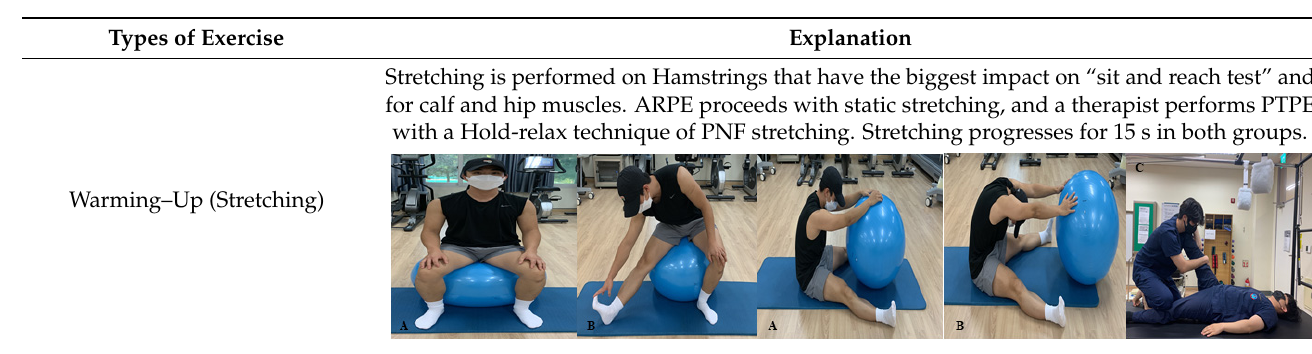
Figure 5. Comparison of static balance between groups after intervention: ( a ) WDI; ( b ) ST. Table 3. Proprioceptive exercise program.